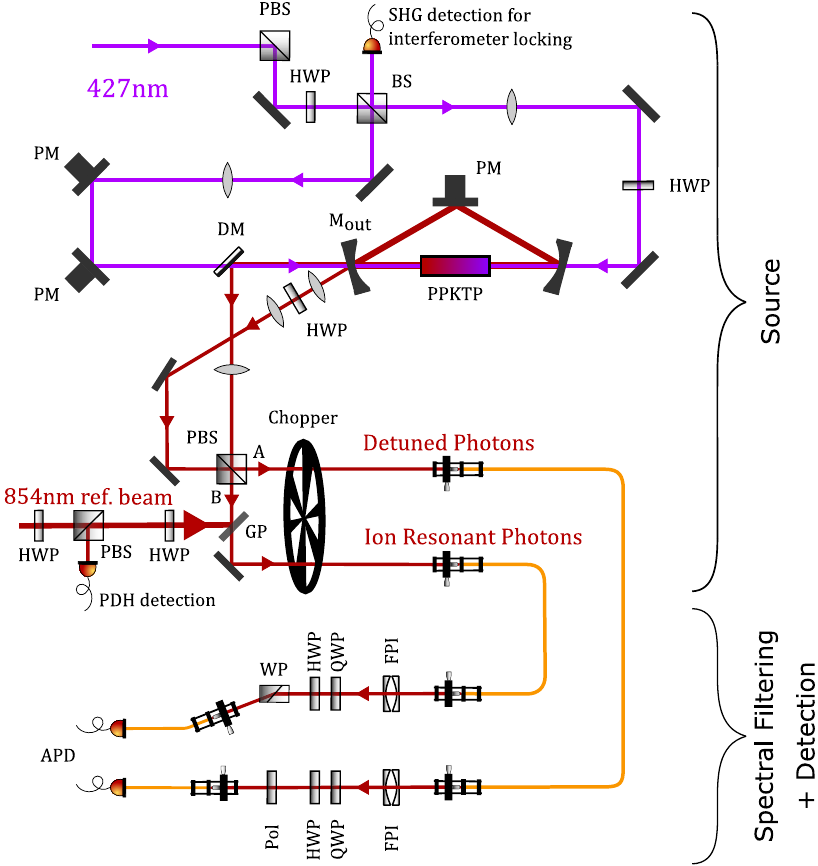
Fig. 1 Schematic of the photon pair source including fi ltering and detection. SPDC source in interferometric con fi guration with PDH locking beams. Stabilization of the resonator and the interferometer is achieved by piezo-driven mirrors (PM). During the stabilization runs, the photons are switched off by an optical chopper in order to protect the APDs. HWP/QWP half-/quarter-wave plate, PBS polarizing beamsplitter, BS non-polarizing beamsplitter, DM dichroic mirror, Pol polarizer, WP Wollaston prism, GP glass plate, PM piezo-driven mirror, FPI frequency fi